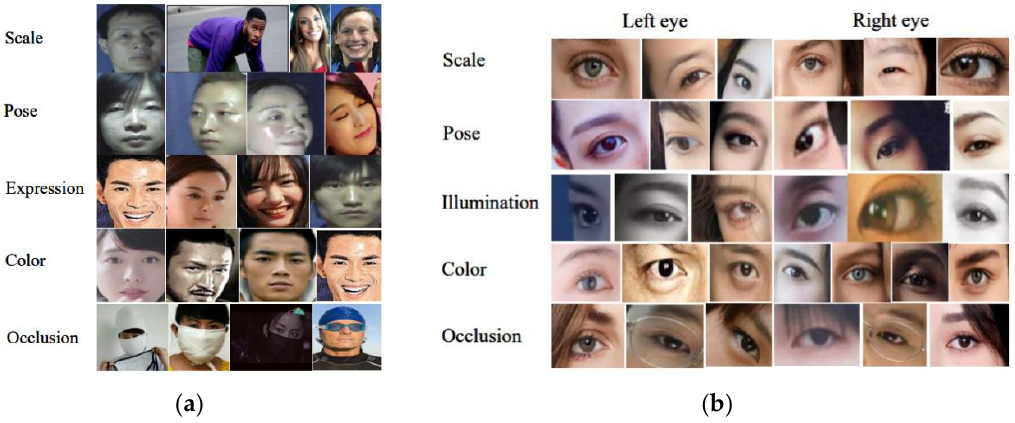
Figure 1. Sample images of ( a ) the eye detection and ( b ) eye image segmentation datasets. An appropriate dataset is essential for eye detection and eye image